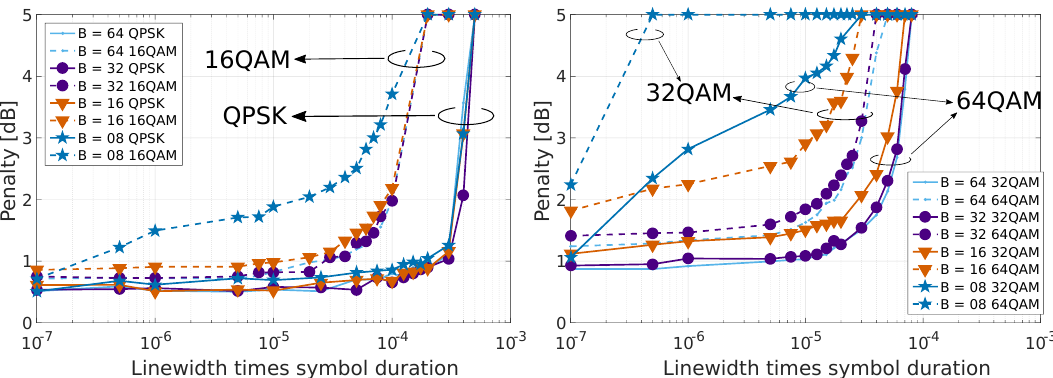
Figure 5. Phase noise penalties for a single-mode fiber (SMF) transmission system (1 mode) and the BPS algorithm for ( left ) quadrature phase-shift keying (QPSK) and 16-quadrature amplitude modulation (QAM) modulation formats and ( right ) 32-QAM and 64-QAM modulation